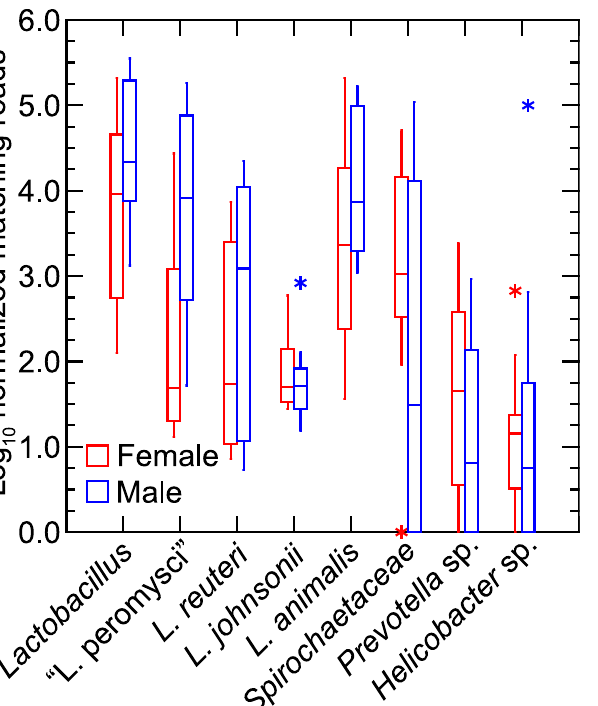
Fig 14. Box-whisker plots of log-transformed normalized reads of fecal metagenomes of 5 female (red) and 4 male (blue) P . leucopus of a natural population of Block Island, Rhode Island. The reference genomes and other sequences were those described for Fig 13 and in addition the partial chromosome sequence of Spirochaetaceae sp. LL50. As an estimate of the number of mammalian cells in the extract, “nuclei” corresponded with normalized reads mapped to P . leucopus genome. Points at a greater distance from the median than 1.5 times the interquartile range are plotted as asterisks.